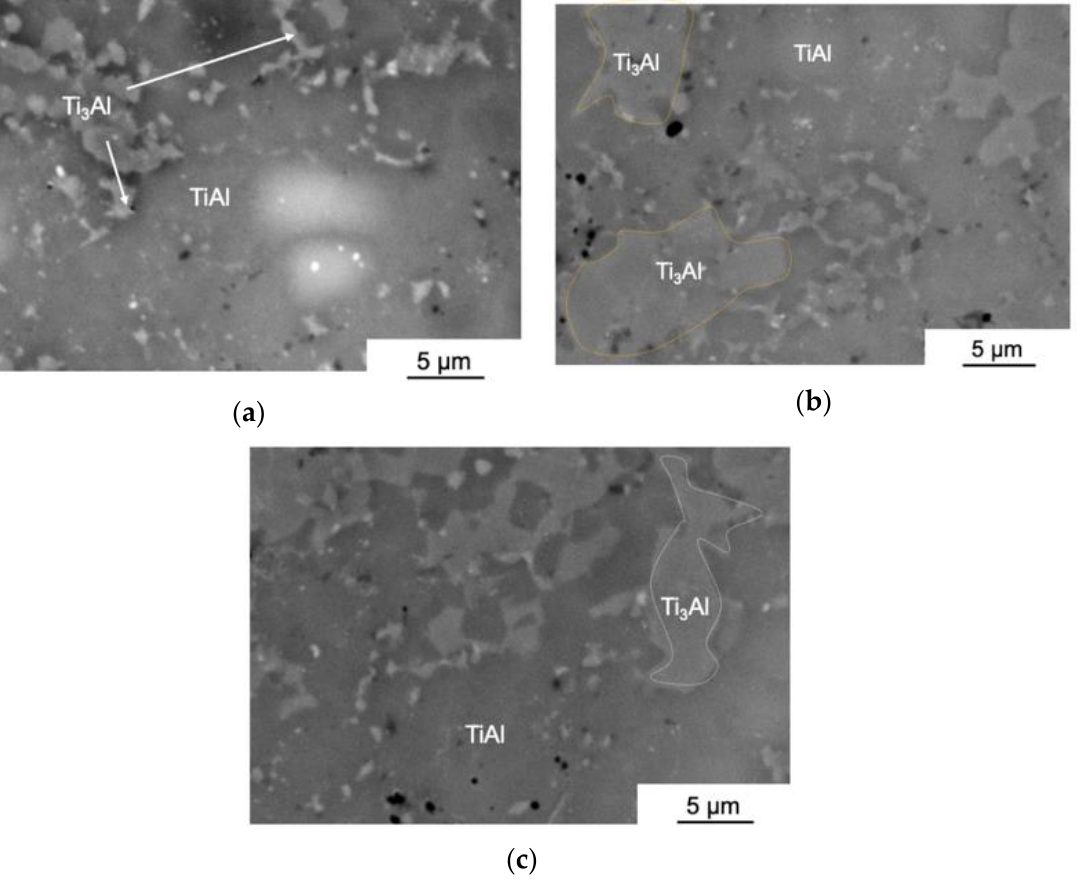
Figure 2. The SEM images of the as-HIPed alloys: 0.2C ( a ), 1.5Si ( b ), and 1.5Y 2 O 3 ( c ). The average grain size of γ -TiAl was 12.5 µ m and that of α 2 -Ti 3 Al was 5 µ m.